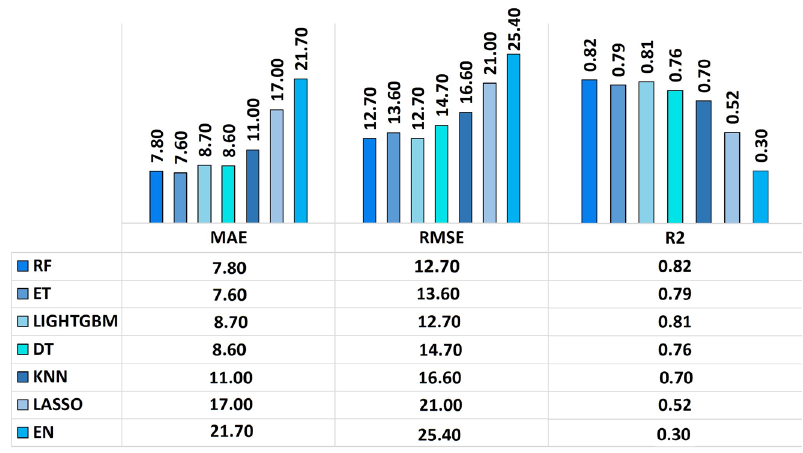
Figure 1. External models’ validation metrics from the test dataset (30%). Comparison of the seven regression models (columns used for this evaluation includes type of NMs, medium used, core-size, shape, synthesis techniques, coating, dosage, absorbance, duration.